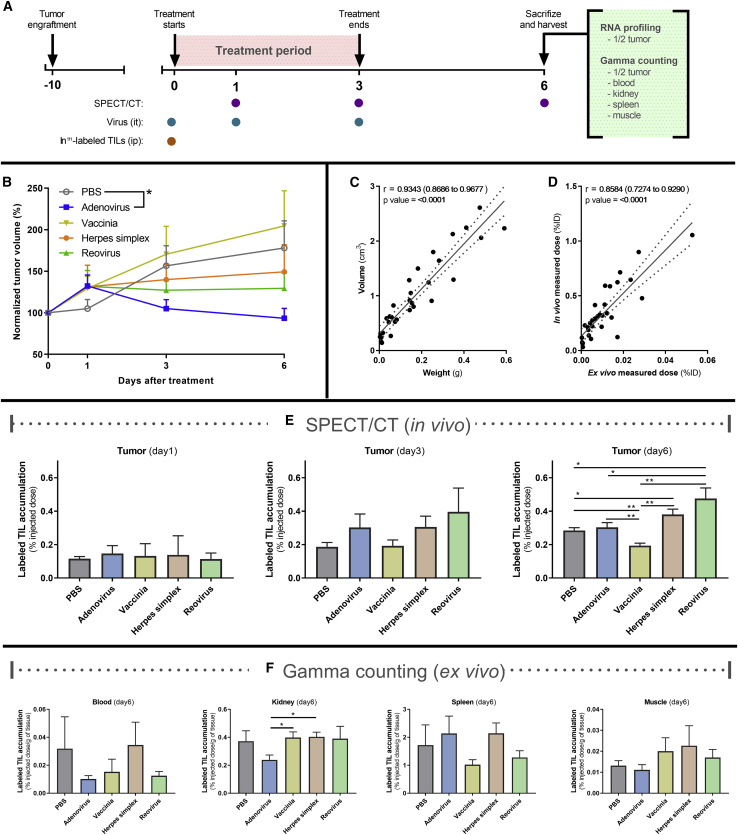
Tracking of Systemically Administered TILs after Oncolytic Virus Intratumoral Injection(A) Experimental design: thirty-four Syrian hamsters carrying subcutaneous HapT1 tumors were randomized into groups and treated with 111indium-labeled TILs intraperitoneally and PBS or one of the studied viruses intratumorally. During the experiment, animals were imaged with SPECT/CT to quantify the biodistribution of the injected TILs. At the end of the experiment, animals were euthanized, and different organs were harvested for ex vivo111indium measurement or in the case of tumors, also for multiplexed RNA sequencing. (B) Normalized tumor volumes for the different groups (n = 6–8). (C) Correlation between tumor volumes measured using CT and the weight of those tumors after they were harvested. (D) Correlation between the in vivo radiation signal measured with SPEC/CT and the ex vivo samples measured by gamma counting. (E) TIL-associated radiation of tumors measured in vivo with SPECT/CT on days 1, 3, and 6. (F) TIL-associated radiation measured ex vivo on different tissues by gamma counting on day 6 (∗p < 0.05; ∗∗p < 0.01). All error bars are SEM; ∗p < 0.05; ∗∗p < 0.01.